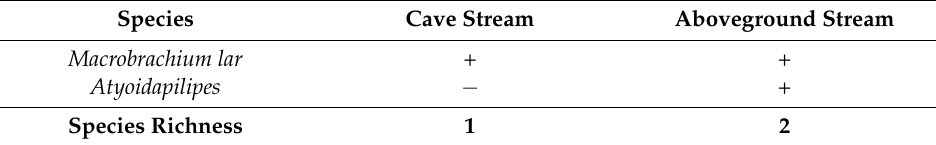
Table 11. Freshwater shrimp species